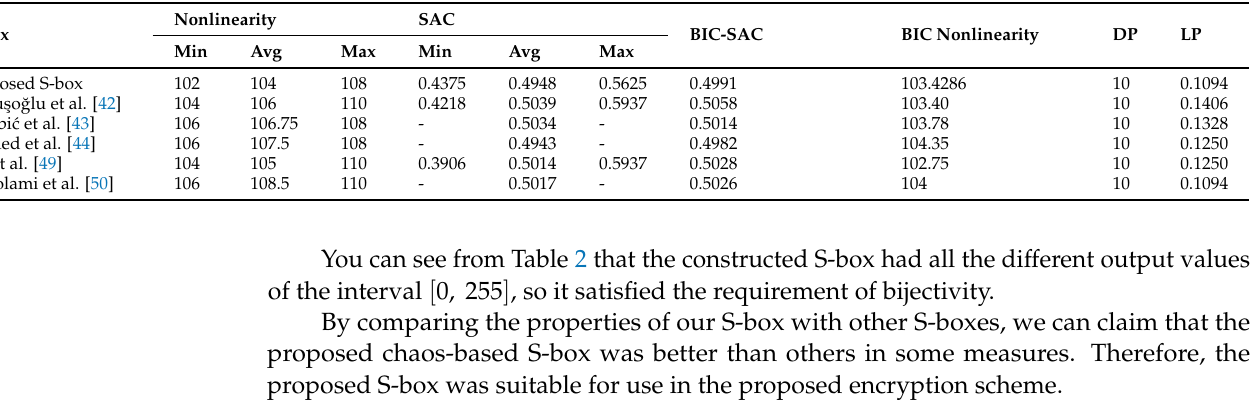
Table 6. Performance comparison of different